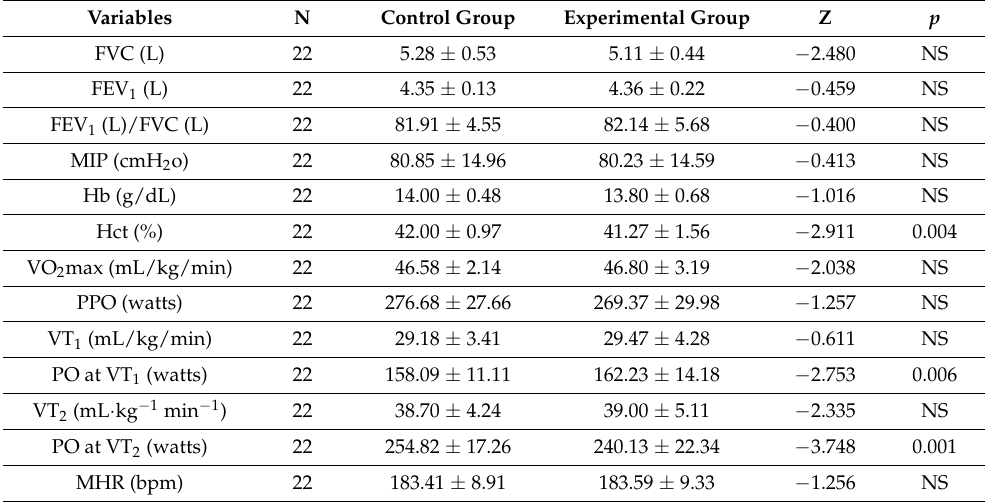
Table 4. Comparison of baseline values of pulmonary and hematological functions and biomarkers of cardiorespiratory fitness between the experimental and the control